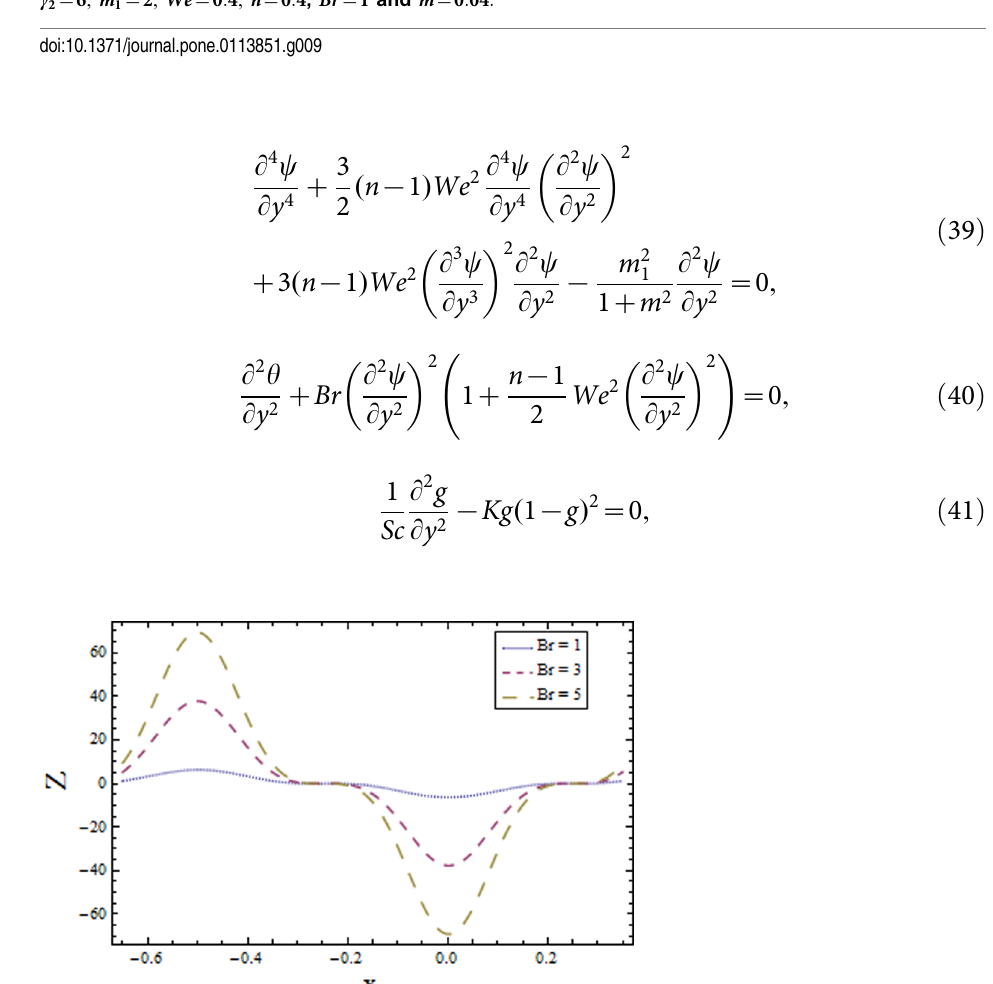
Figure 9. Plot of heat transfer coefficient Z for wall parameters E 1 , E 2 , E 3 , with E ~ 0 : 1 , t ~ 0 : 01 , ª 1 ~ 4 , ª